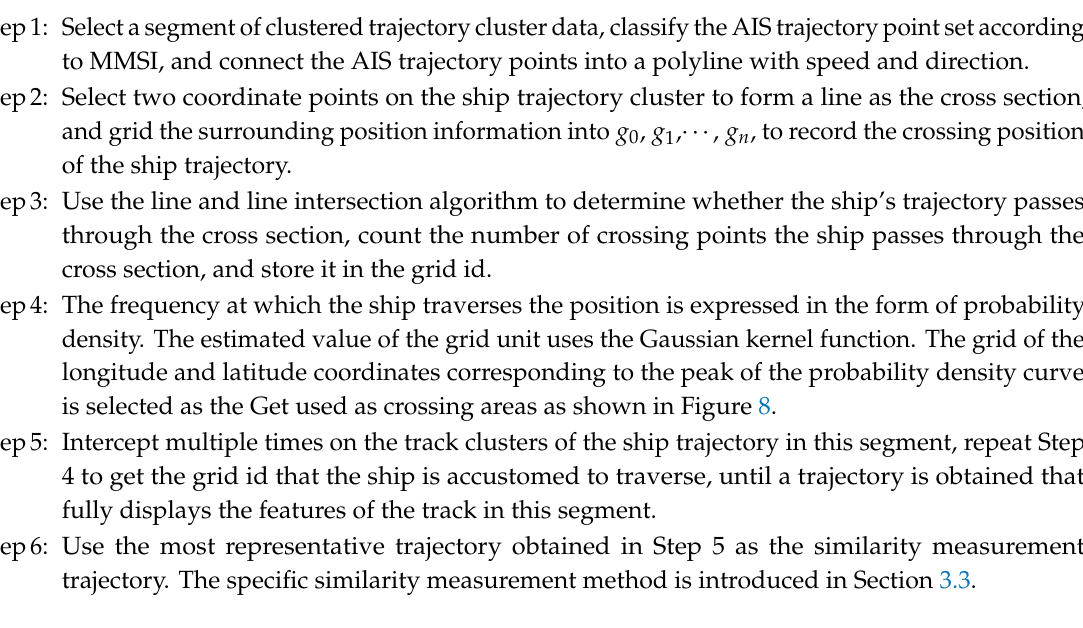
Figure 6. Trajectory clusters by DBSCAN. Each color cluster represents a different densest waterway .